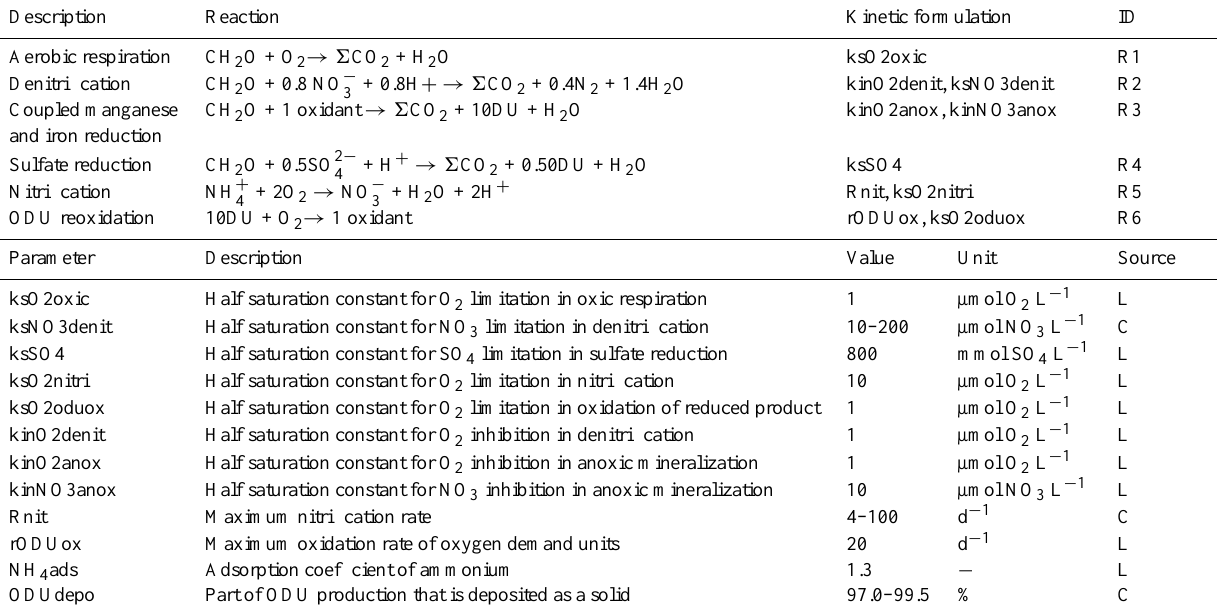
Table 2. Biogeochemical reactions and parameters/constants used in the model.